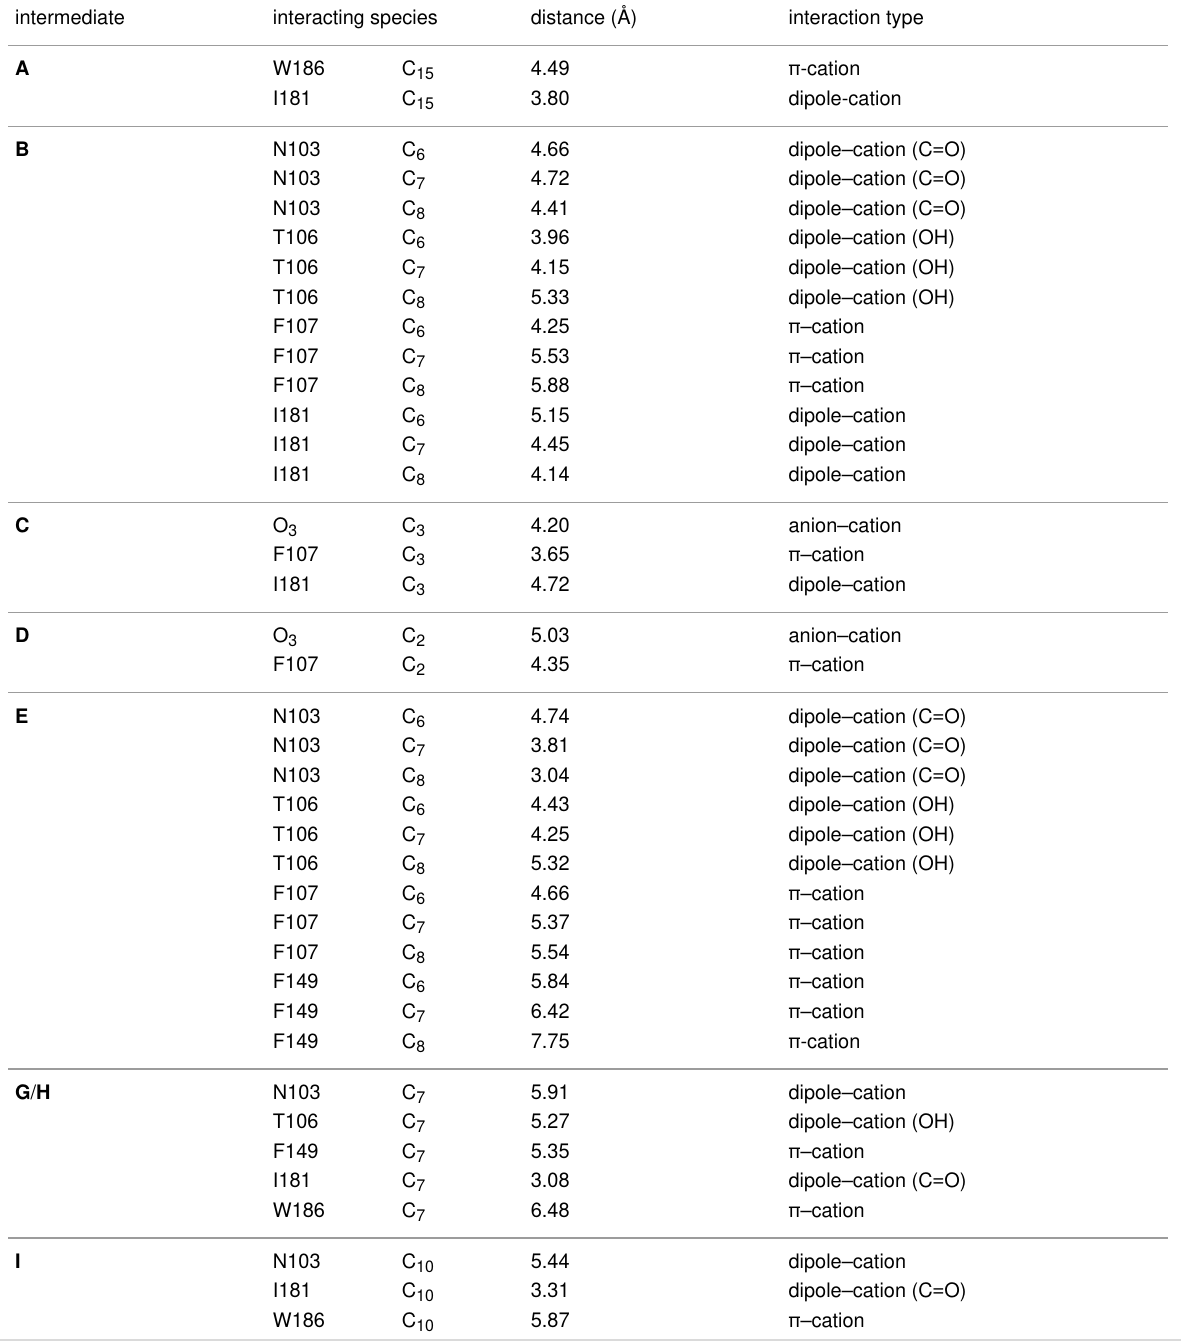
Table 1: Interactions between intermediates and TS structures with active site residues.